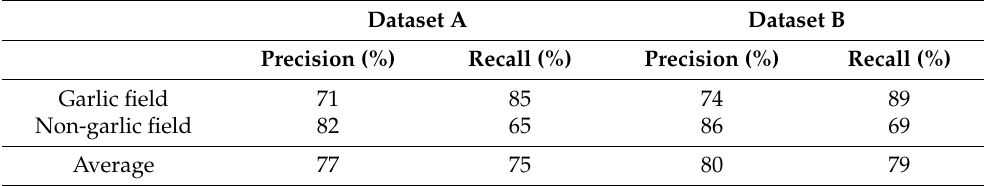
Table 16. Precision and recall of garlic classification model generated using the k -NN method.